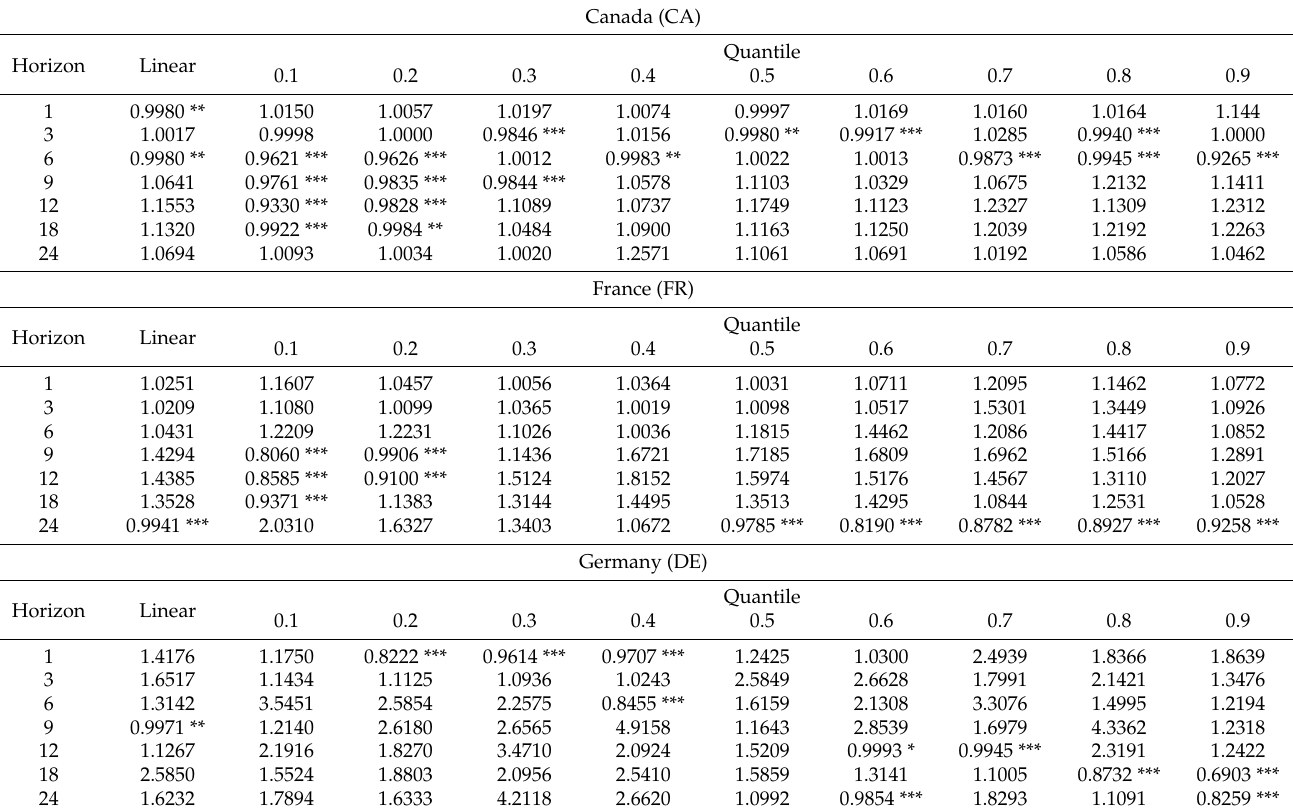
Table 1. Forecasting